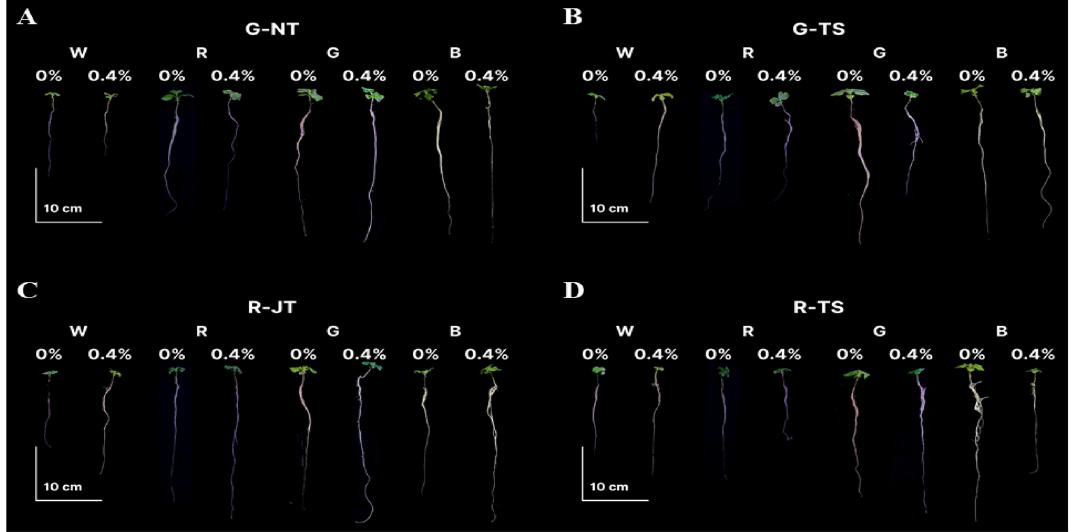
Figure 4. Early plant growth from four light treatments; white LEDs (W), monochromic red (R), green (G) and blue (B) LEDs with 0% and 4% of KNO3 priming among four holy basil varieties; G-NT ( A ), G-TS ( B ), R-JT ( C ) and R-TS ( D ) subsequently grown with white LEDs for 15 days under fully controlled